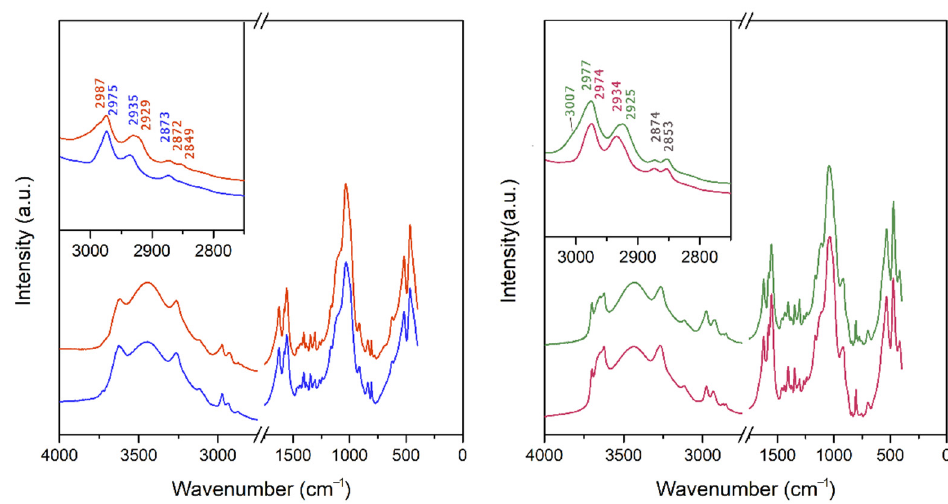
Figure 12. Comparison of the C–H regions: (left) the FTIR spectra of A-Mt (blue) and A-TMP-Mt (red); and (right) the FTIR spectra of A-Bd (magenta) and A-TMP-Bd (green).